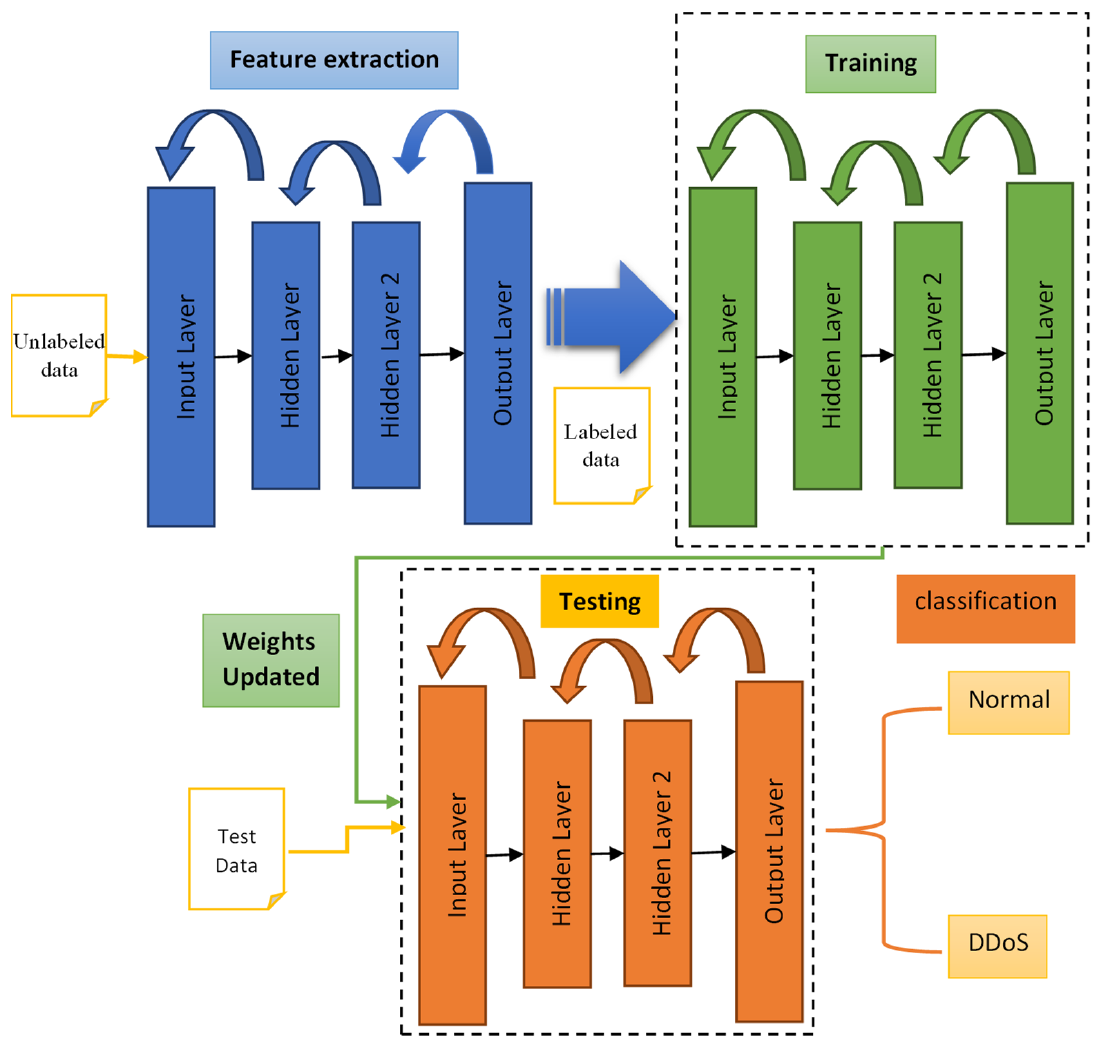
Figure 1. Proposed deep-learning model with autoencoder structure.